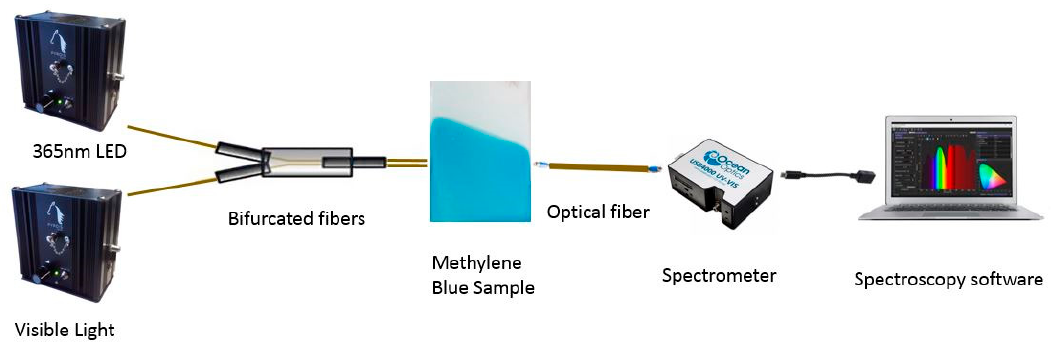
Figure 2. Experimental setup used to monitor the photocatalytic efficiency of the electrospun fibers doped with a methylene blue solution after irradiation with both 365 nm LED and visible light.